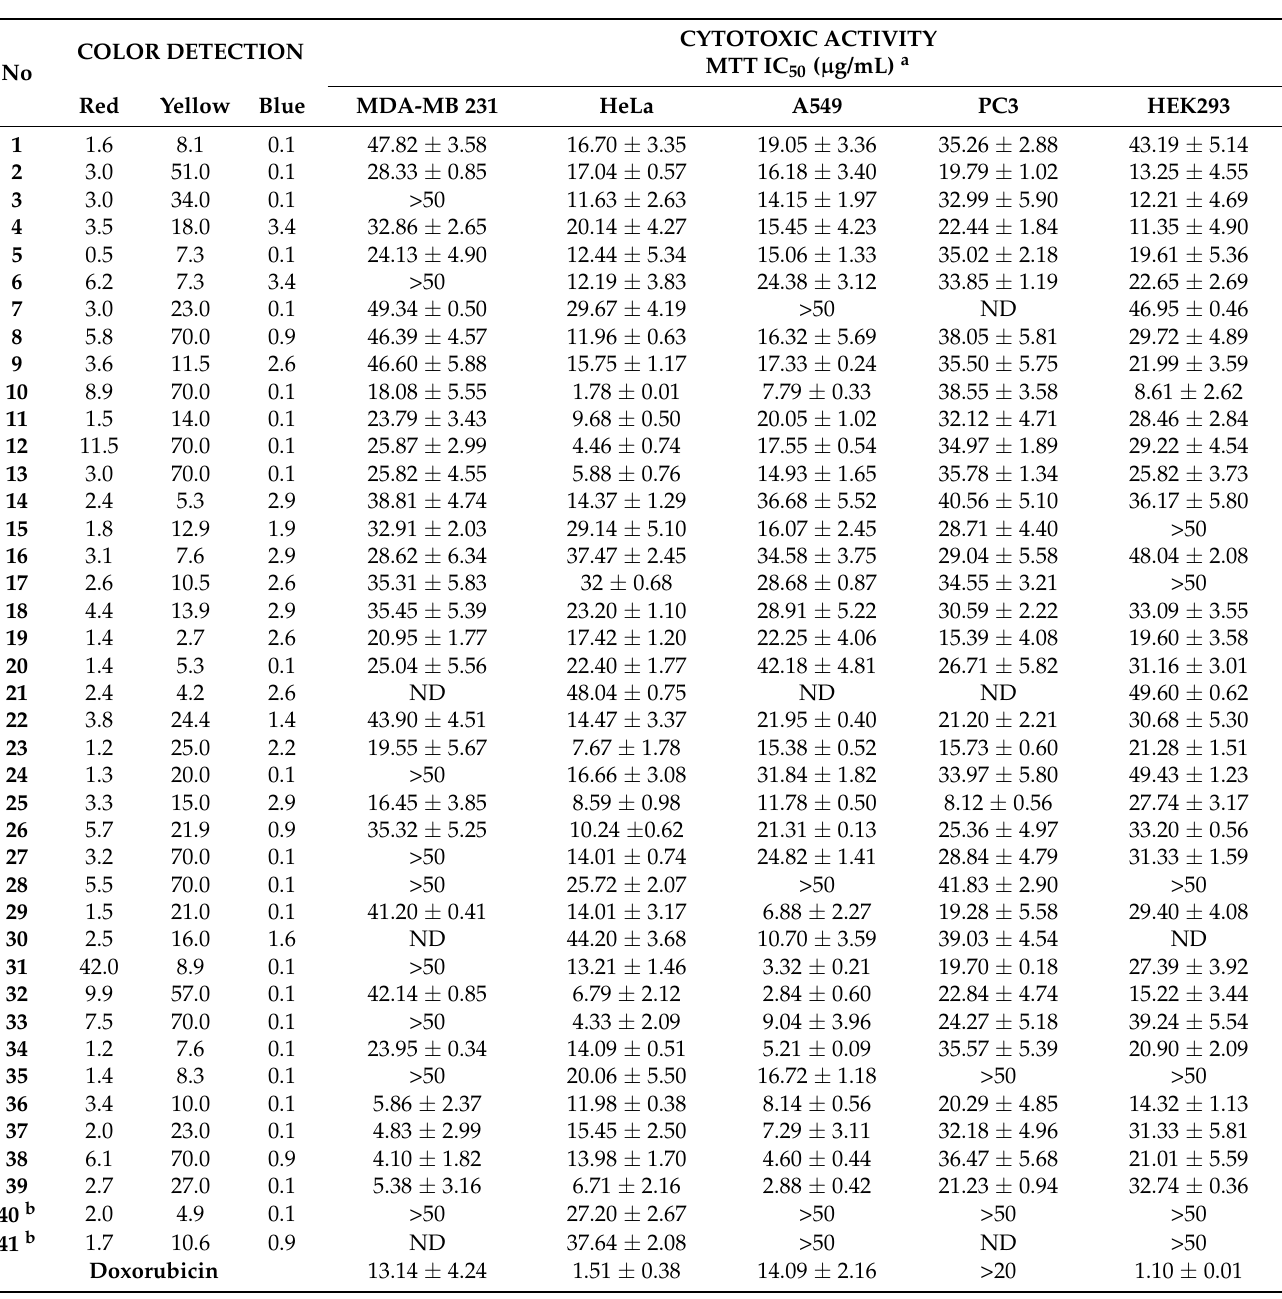
Table 2. Cytotoxic activity results and color index of propolis samples collected from